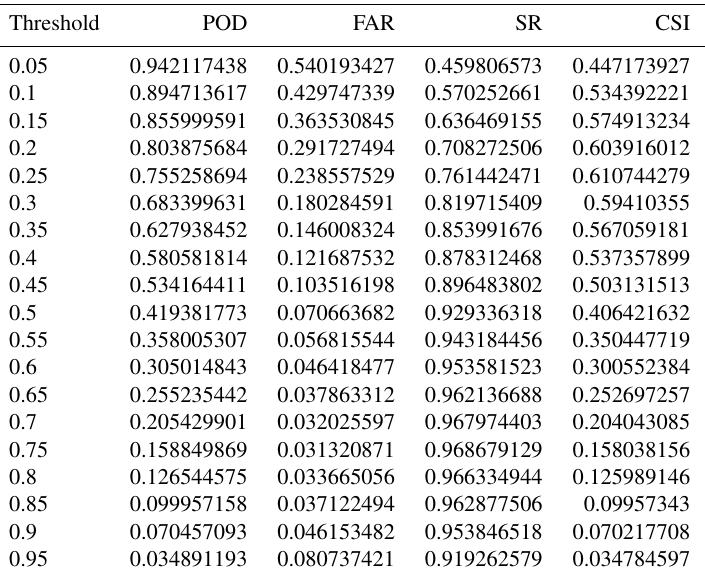
Table A3. POD, FAR, SR, and CSI values for using different thresholds in the standard training